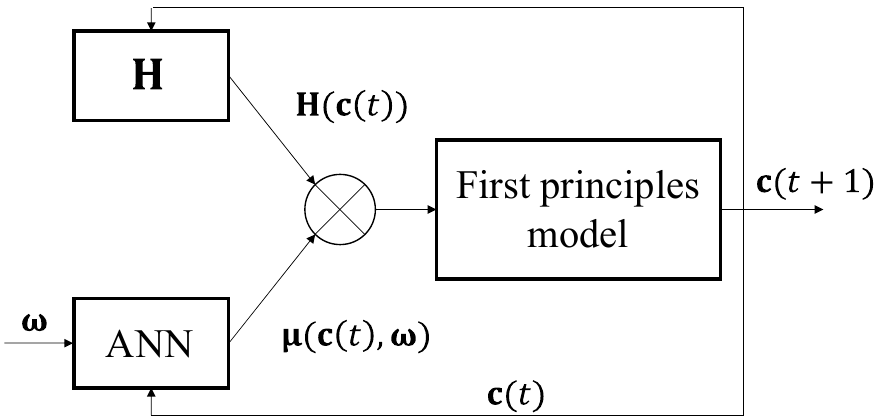
Figure 2. Example of batches generated in silico through the FPDM: ( a ) VCC profiles and ( b ) mAbs titer profiles for 100 batches. The thick red continuous lines represent the reference batch estimated from the process while the grey dashed lines represent the simulated ones.